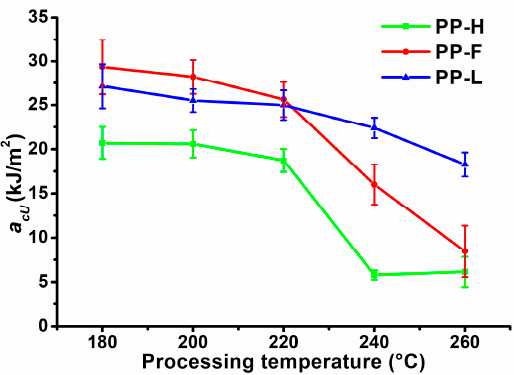
Figure 6. Unnotched Charpy impact strength of composites processed at different temperatures.